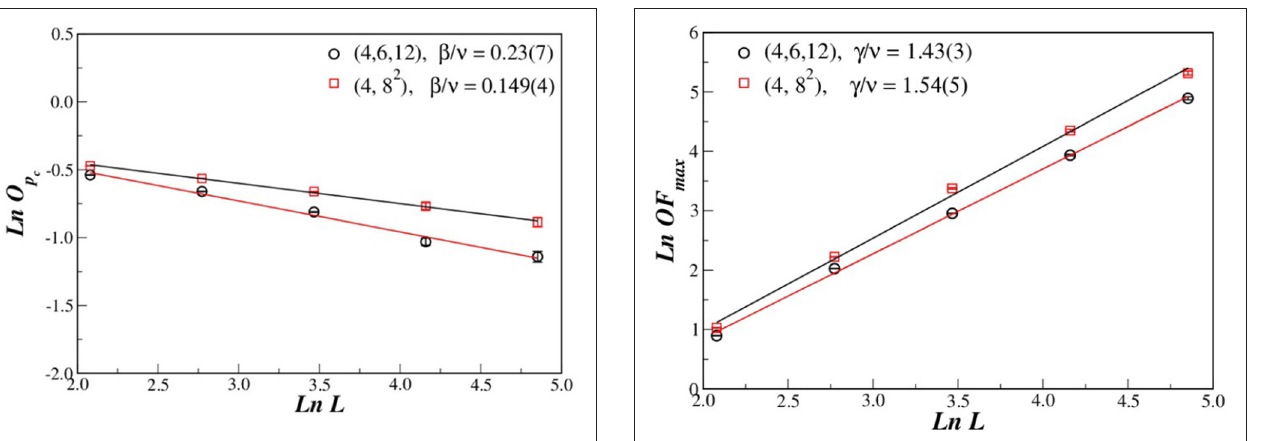
FIGURE 3 | Log-log plot of the dependence of the opinion O * = O ( p c ) on the linear system size L . Fitting data, we obtained the estimation for the critical ratio β/ν .